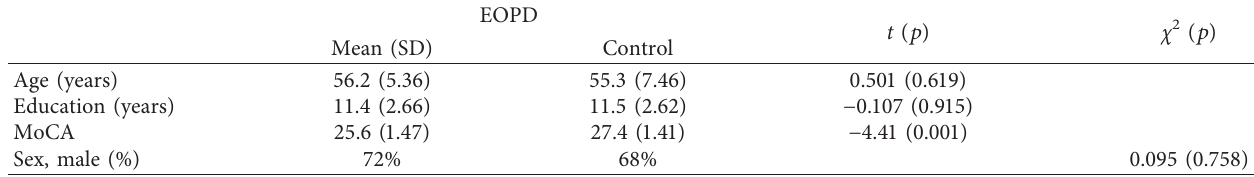
Table 2: Demographic characteristics and general cognitive ability of the EOPD ( n � 25) and control ( n � 25)